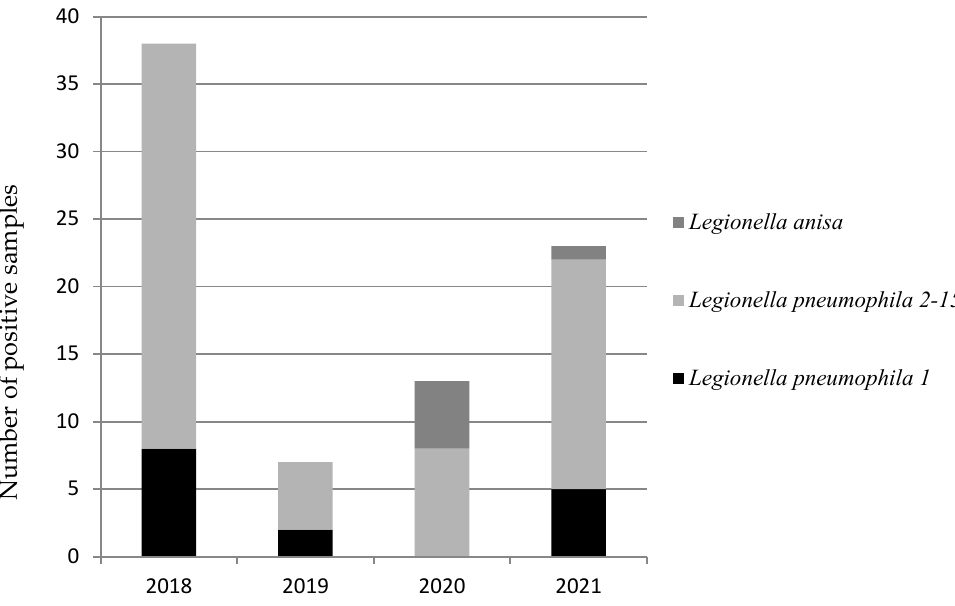
Figure 1. Total number of positive samples related to the bacterial load of L. pneumophila. and L. anisa isolates. For each of the three clusterings ( L. pneumophila sgr 1, L. pneumophila sgr 2 ‐ 15, L. anisa ), the greatest number of positive samples had a load within the lowest range, the value of which has been established by Italian ministerial guidelines. Figure 2 shows the annual trend of the different L. pneumophila serogroups and L. anisa.